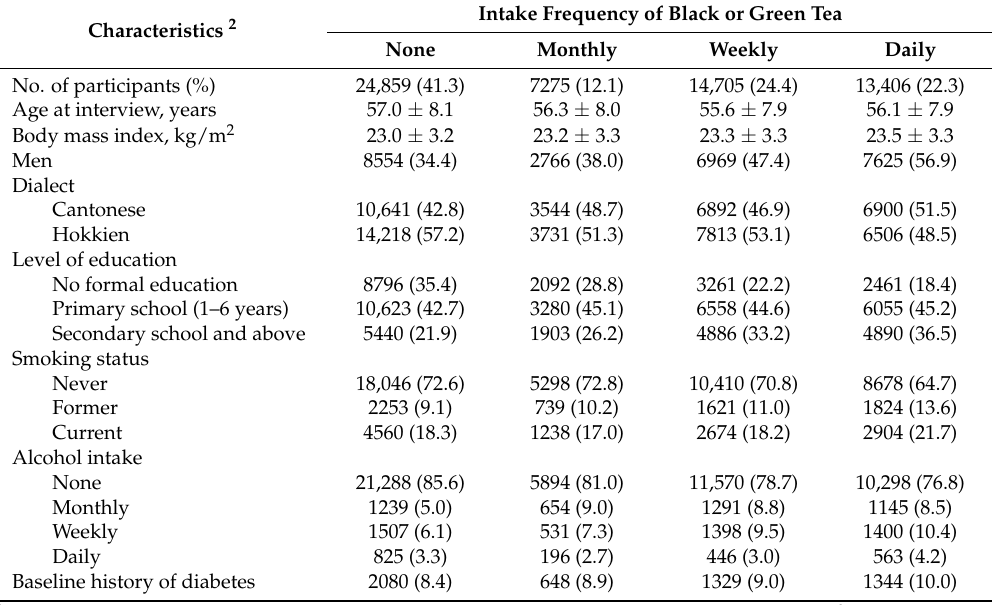
Table 1. Baseline characteristics of participants according to frequency of tea consumption 1